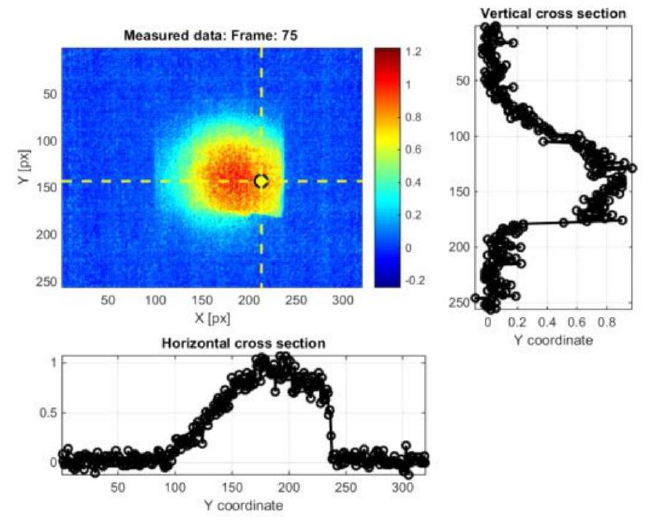
Figure 10. Laser-spot thermography result on fatigue damaged aluminium sample, from 92.